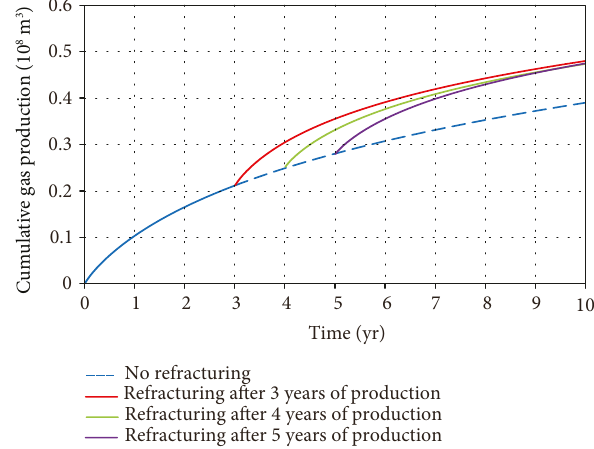
Figure 6: Cumulative gas production for di ff erent refracturing